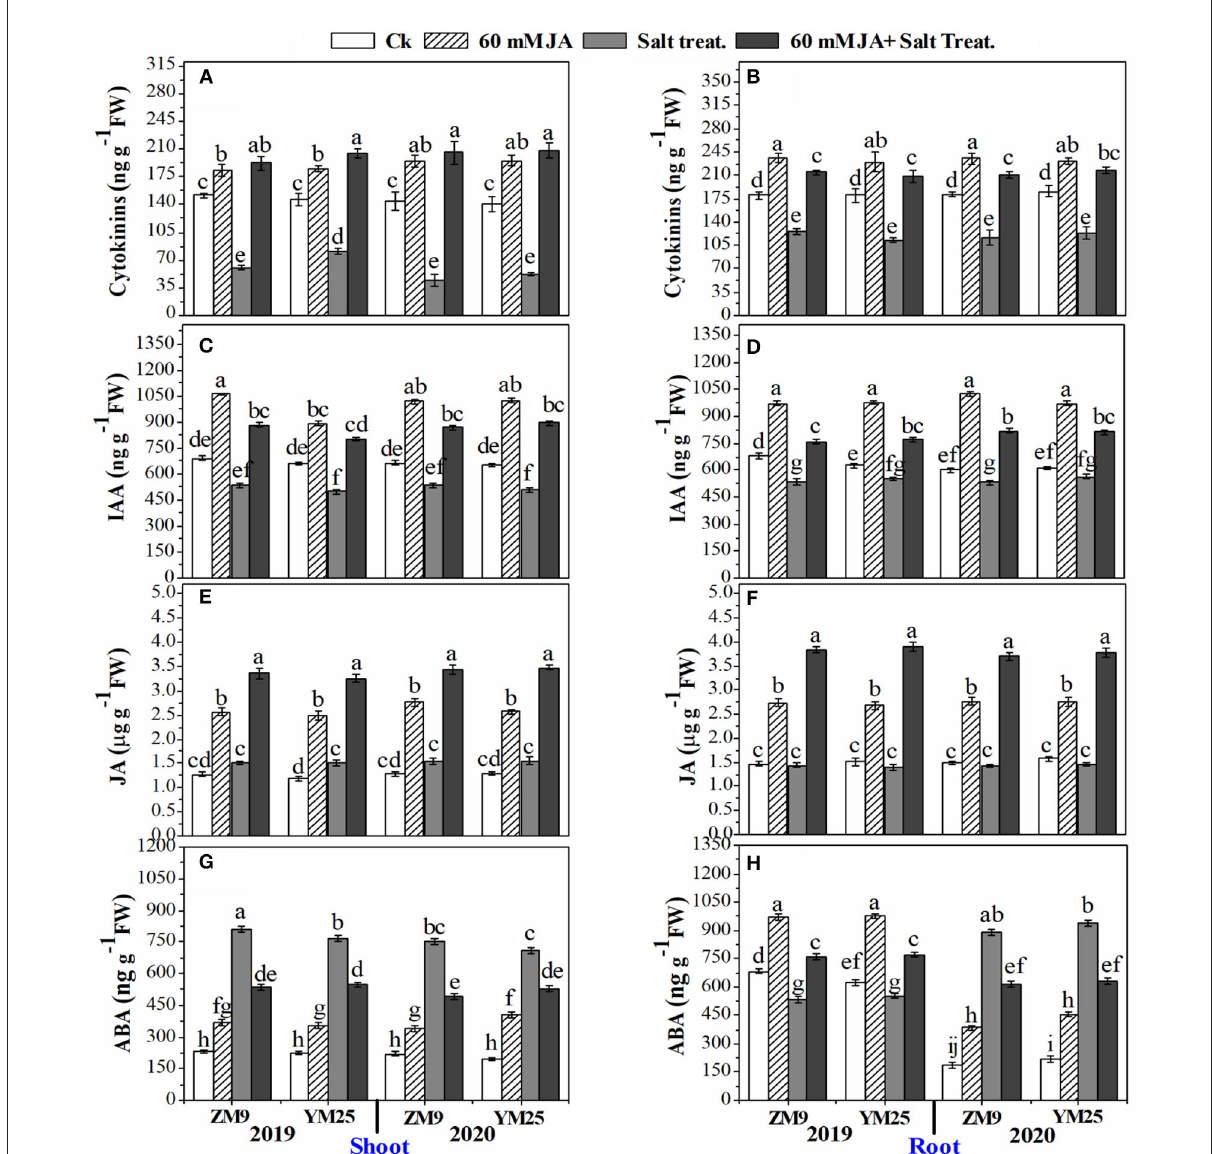
FIGURE4 Effects of JA priming on cytokinins in the shoot (A) and root (B) ; IAA in the shoot (C) and root (D) ; JA in the shoot (E) and root (F) ; ABA in the shoot (G) and root (H) of two wheat cultivars Mai9 (ZM9, salt-sensitive) and Yang Mai25 (YM25, salt-tolerant) under control and salinity stress conditions during two consecutive growing seasons 2019 and 2020. Means sharing the same letters, for a parameter during a year, do not differ significantly at P ≤ 0.05 among the studied factors. IAA, indole acetic acid; JA, jasmonic acid; ABA, abscisic acid; Ck, control; S, salt